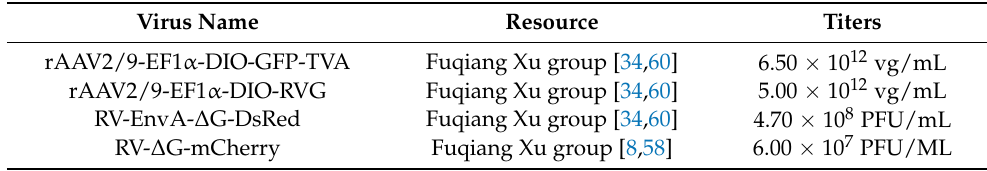
Table 1. Viruses used for retrograde